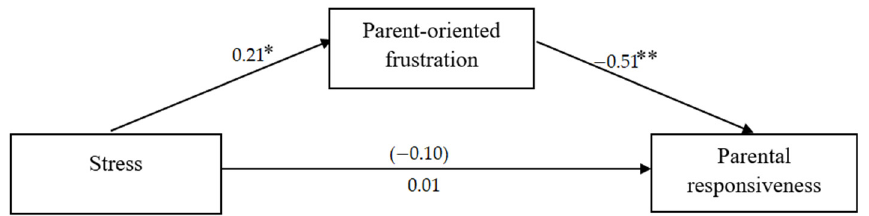
Figure 2. Mediation model for women (standardized coefficients are reported; total effect in paren- thesis). Note. * p < 0.05, ** p < 0.01.